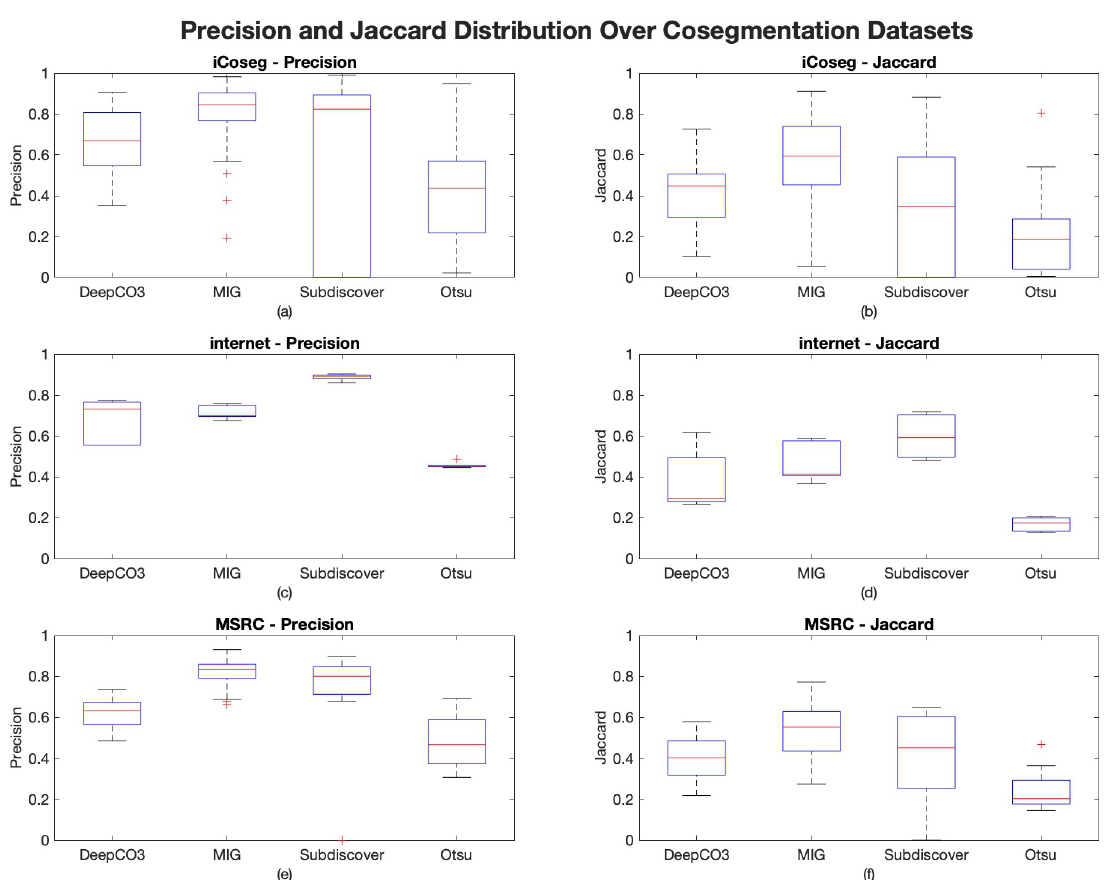
Fig 3. Precision and Jaccard distribution over all the cosegmentation datasets from the benchmark analysis. (a) and (b) are Precision and Jaccard distributions for iCoseg, respectively. (c) and (d) are the Precision and Jaccard distributions for Internet, respectively. (e) and (f) are the Precision and Jaccard distributions for MSRC,